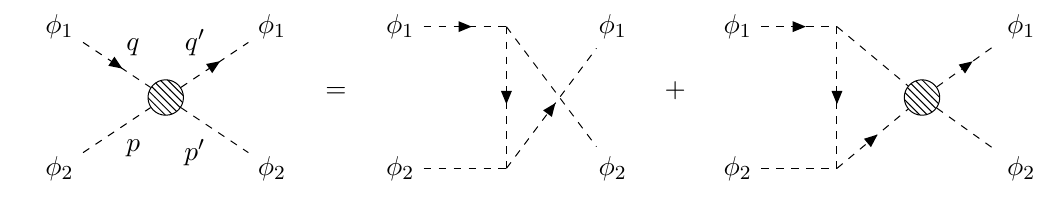
Figure 2 . Feynman diagrams for φ 1 φ 2